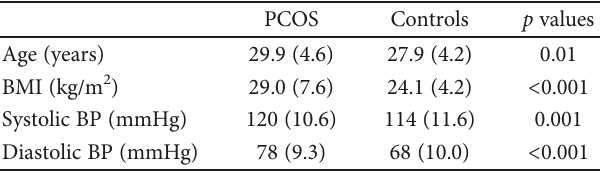
Table 1: Baseline characteristics of the study participants.